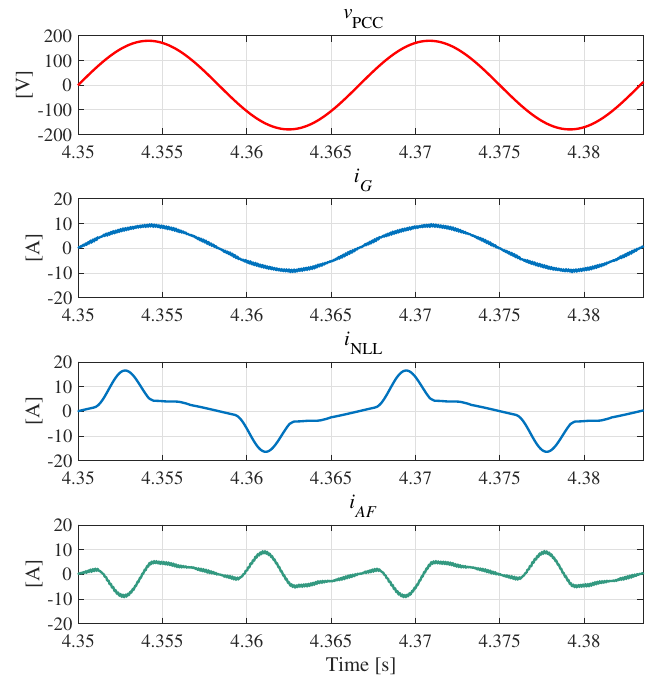
Figure 5. Steady state responses of the voltage at the PCC v PCC , the line current i G , the current consumed by the NLL i NLL , and the injected current i AF .